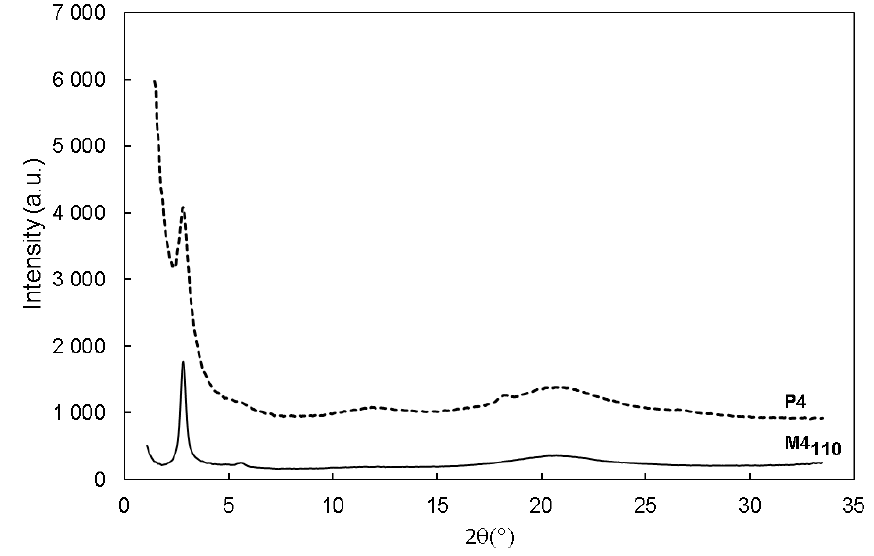
Figure 2. X-ray powder diffraction (XRD) diffractograms of thiophene-and-polythiophene-based hybrid materials M4 110 and P4 .